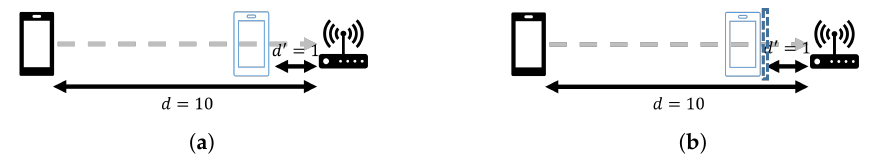
Figure 6. Schematic of the RVPV environment: ( a ) LOS condition; ( b ) NLOS condition.